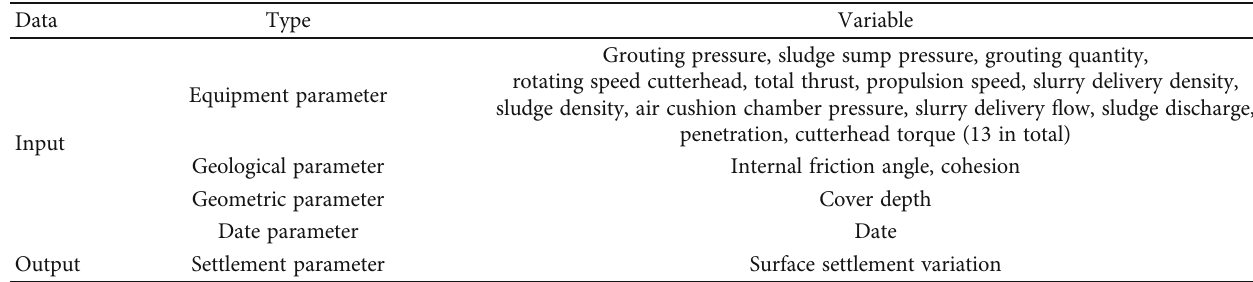
Figure 9: Variation curve of surface settlement at point DBC-1058. Table 3: Parameters of the prediction model.